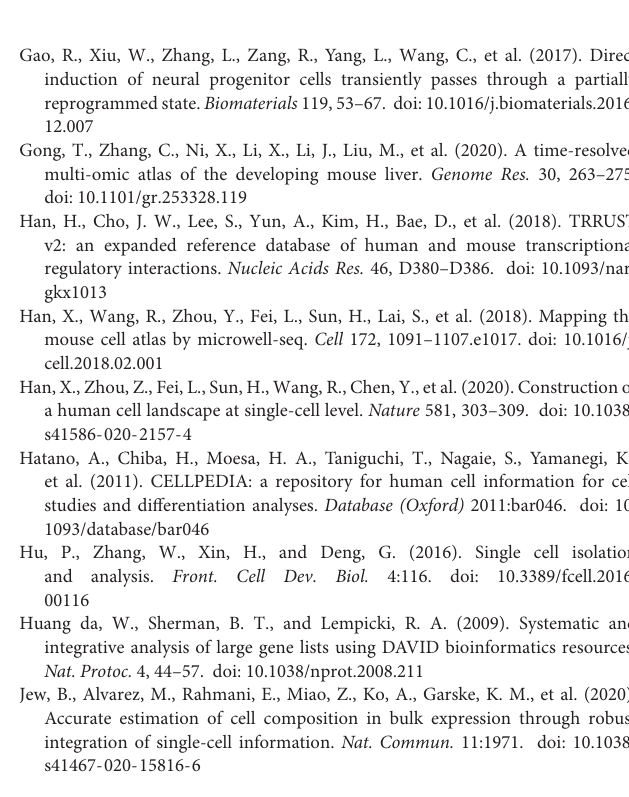
Supplementary Figure 1 | Cell fractions of 101 cell types in bulk samples from developing mouse livers. Cell fractions of 101 cell types in the bulk samples from Renaud et al. data (A) and Gong et al. data (B) were estimated by CIBERSORTx. The samples from different time points are indicated. The names of cell types with fold change > 2 or fold change < 0.5 are listed in the figures, and the names of all cell types are listed in Supplementary Table 1 . Supplementary Figure 2 | Cell fractions of 101 cell types in bulk samples from cultured giNPCs. The samples from different time points are indicated. The names of cell types with fold change > 2 are listed in the figure, and the names of all cell types are listed in Supplementary Table 1 . Supplementary Figure 3 | Cell fractions of 101 cell types in bulk samples from in vivo and in vitro developing mouse retina. Cell fractions of 101 cell types in the bulk samples from in vivo (A) and in vitro (B) developing mouse retina were estimated by CIBERSORTx. The samples from different time points are